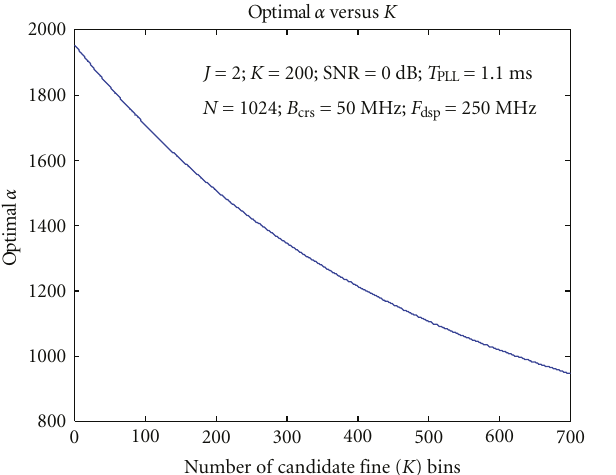
Figure 7: Optimal β versus available coarse channels.